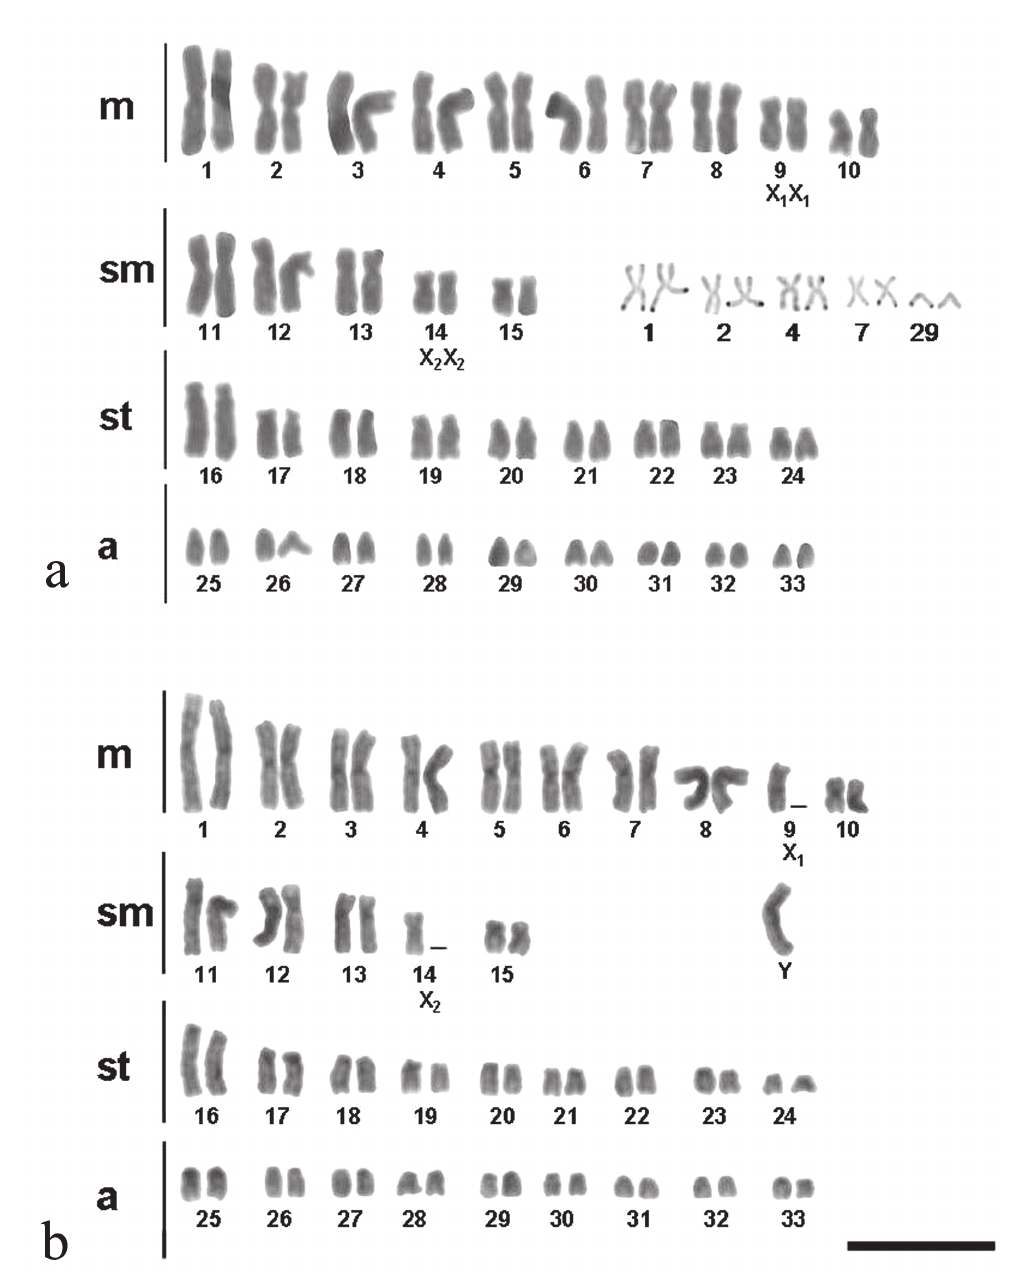
Fig. 5. Karyotypes of female ( a ) and male ( b ) of Potamotrygon falkneri sample from Ilha Solteira, highlighting the sex chromosomes after conventional and the chromosomes marked by NOR. Scale bar = 10 